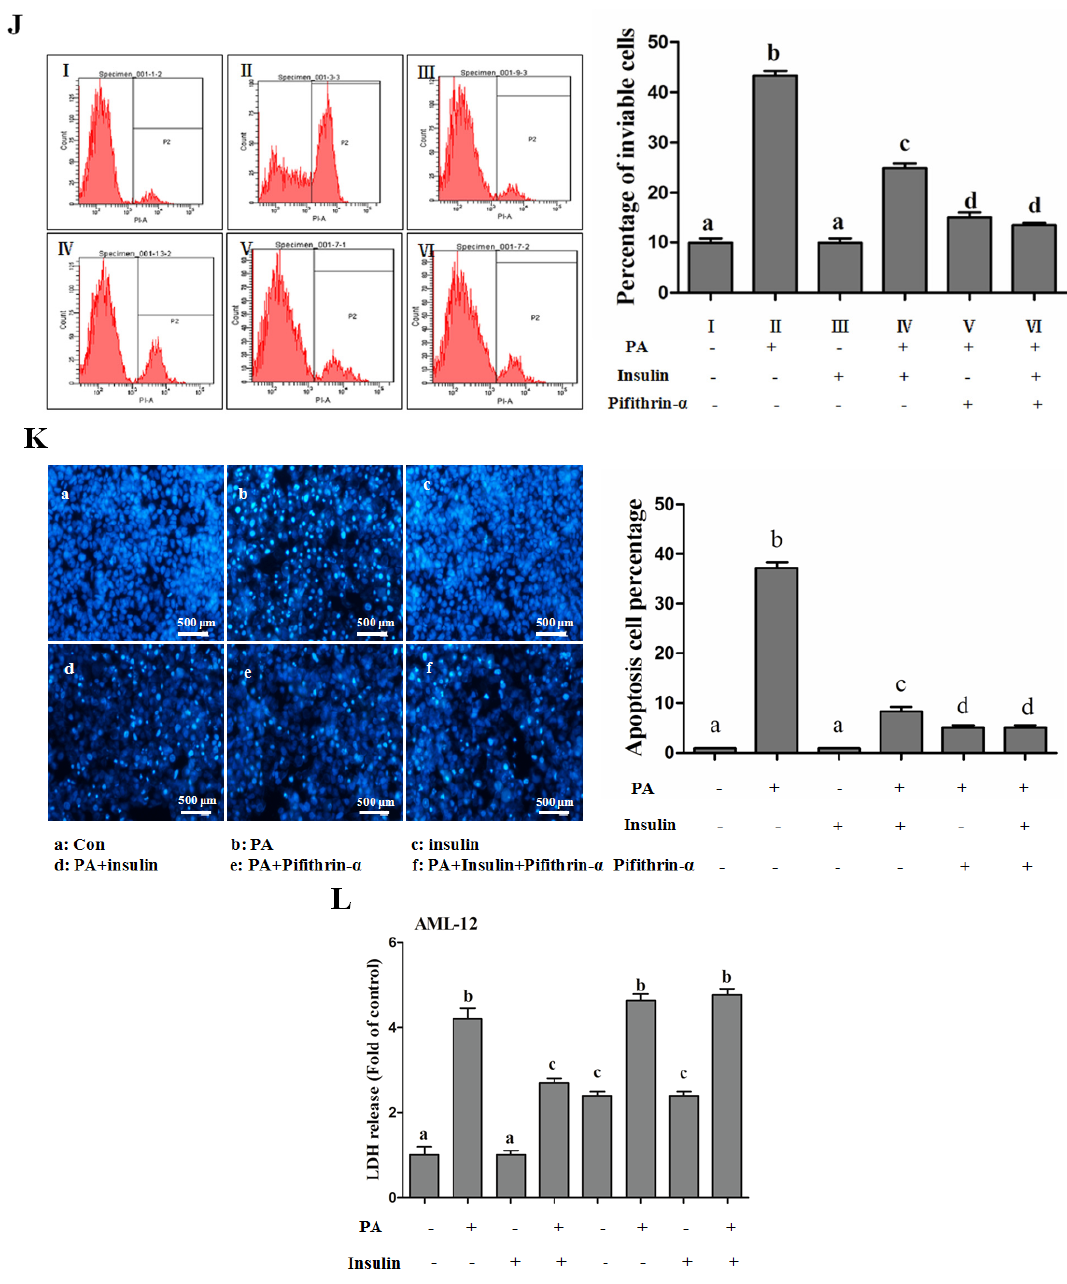
Figure 6. PI3K/Akt ‐ regulated p53 contributes to insulin ‐ protected SFA ‐ induced lipotoxicity via mediating ER stress. HepG2 cells were exposed to palmitic acid (PA, 400 μ M) for 12 h with or without insulin (200 nM) pretreatment for 1 h. PI3K/Akt antagonist ly294002 (10 μ M) or p53 inhibitor pifithrin ‐ alpha (10 μ M) were added 1 h before insulin treatment. The cellular index was detected as follows: ( A ) Intracellular ROS production was measured by DCFH ‐ DA stain using fluorescence microscopy (magnification × 100); ( B ) Immunoblotting assay for GrpP94, Grp78, CHOP, and p53; ( C ) ER stress inhibitor was pretreated for 1 h before exposed to palmitic aced (PA, 400 μ M), LDH in the cultured medium was detected as described in the Methods; ( D , H ) LDH in the cultured medium was detected as described in the Methods; ( E , I ) Immunoblotting assay for phosphorylated Akt, Grp94, Grp78, CHOP p53; ( F , J ) cell death was dectected by propidium iodide staining with flow cytometry; ( G , K ) Nuclear morphology was detected by Hoechst staining using fluorescence microscopy (magnification × 100); ( L ) AML ‐ 12 hepatocytes were used to replace HepG2 cells. LDH in the cultured medium was detected as described in the Methods section. Each test was performed at least 3 times. Bars with different characters differ significantly ( p < 0.05).